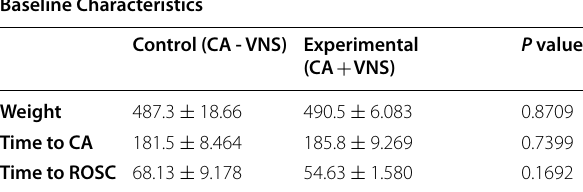
Table 1 Baseline characteristics. No significant difference was observed between groups. N 8 for control and tVNS groups, = respectively. Student’s T-test for comparison between means. CA, cardiac arrest; tVNS, threshold adjusted vagus nerve stimulation; ROSC, return of spontaneous circulation. Mean ±